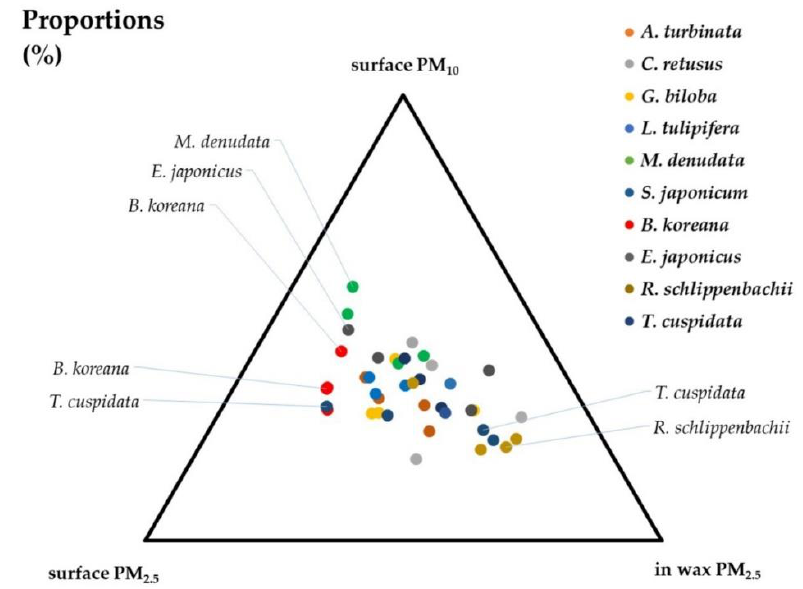
Figure 5. Proportions of surface PM 10 , surface PM 2.5 , and wax PM 2.5 captured on leaf surfaces plotted in the ternary diagram ( n = in the ternary diagram ( n = 200).